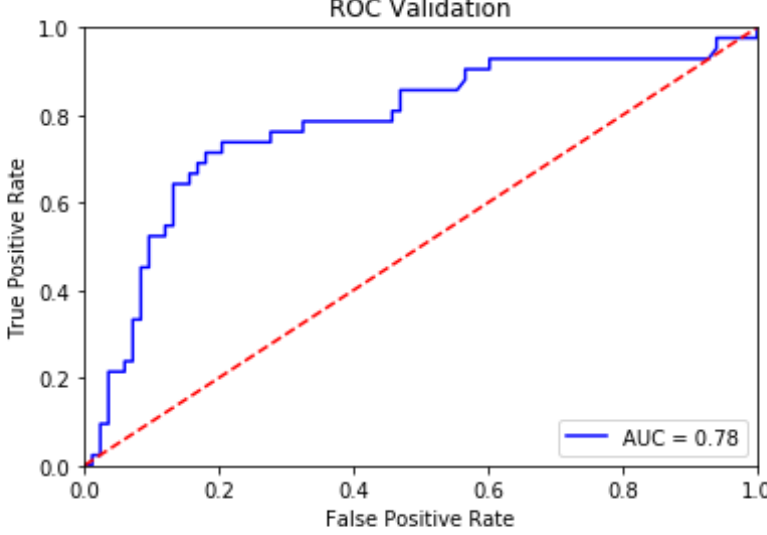
Figure 5. The receiver operating characteristic curve of F-SVM. AUC: area under the curve; ROC: receiver operating characteristic curve.